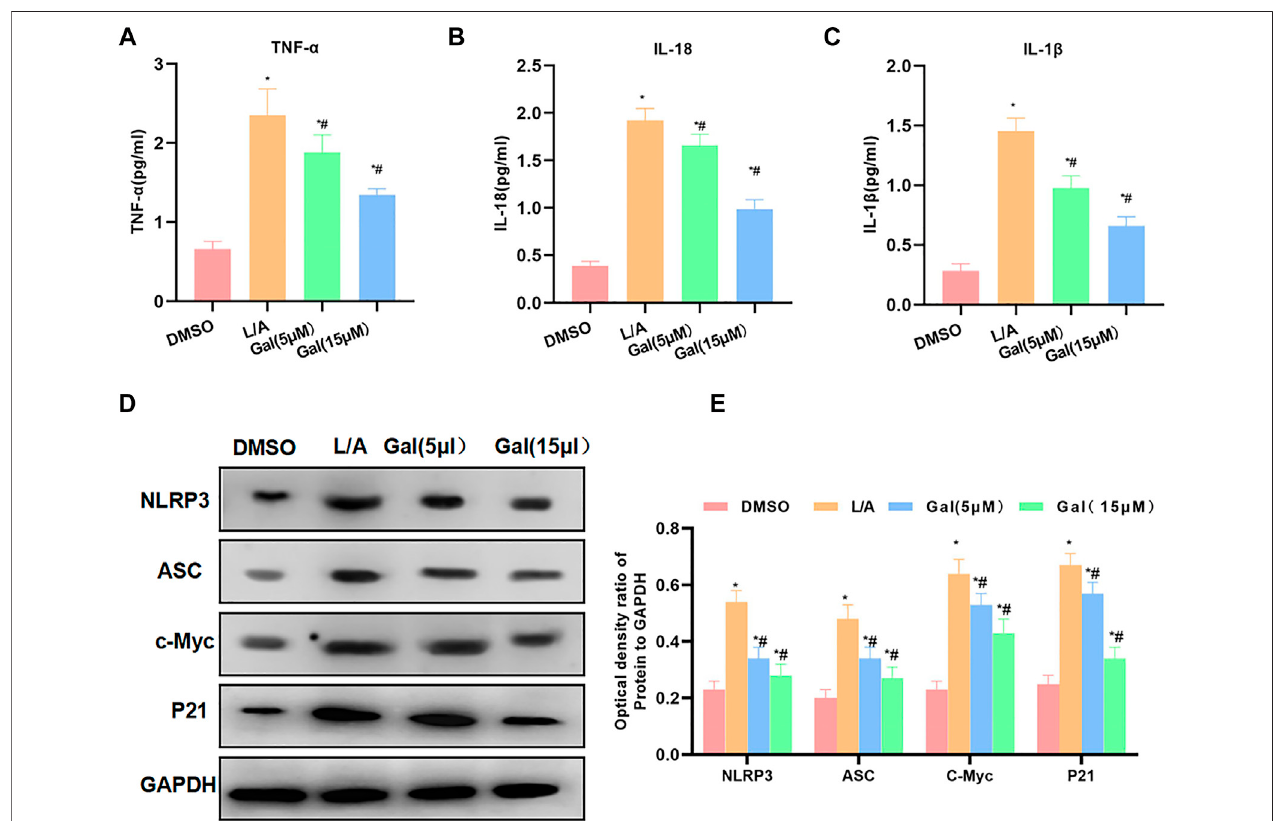
FIGURE 4 | Gallo fl avin inhibited the expression of in fl ammatory factors and NLRP3. (A – C) : Gal could inhibit the expression of in fl ammatory factors in the in fl ammatory microenvironment. The levels ofIL-6,TNF- α ,and IL-1 β ofthe Gal groupwere signi fi cantlydownregulatedthan thatofthe L/Agroup. In addition, high-dose Gal could better inhibit the expression of in fl ammatory factors than low-dose. Comparison with the DMSO group, * p < 0.05; comparison with the L/A group, # p < 0.05. (D,E) : Gal could inhibit the expression of NLRP3, downregulate the levels of NLRP3 and ASC, and suppress the expression of c-Myc and P21. Comparison with the DMSO group, * p < 0.05; comparison with the L/A group, # p < 0.05.